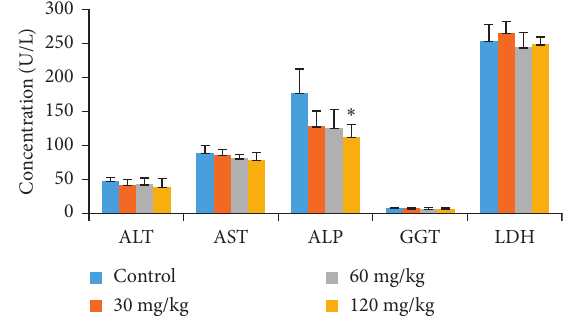
Table 4: The effects of goose bone on serum total bilirubin